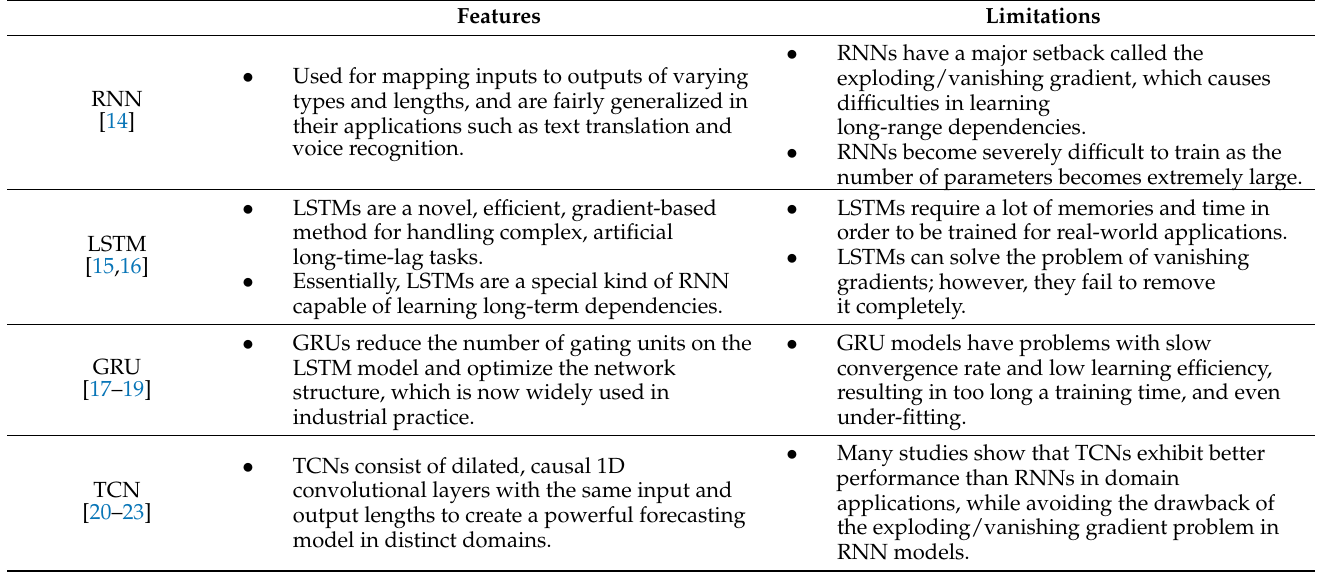
Table 2. Deep Learning Approaches for Wind Power